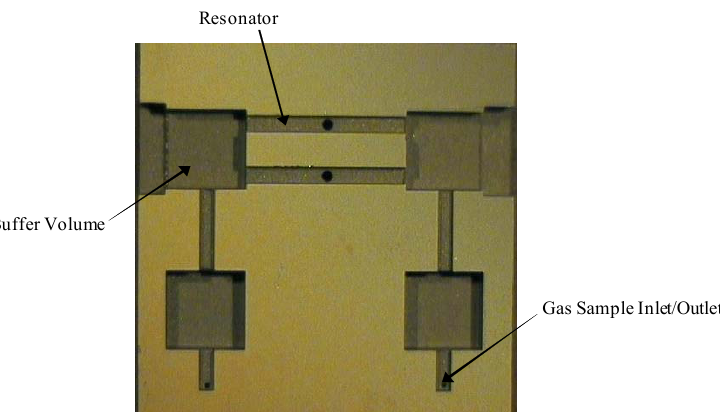
Figure 2. Photograph of the internal structure of the MEMS-scale photoacoustic cell.